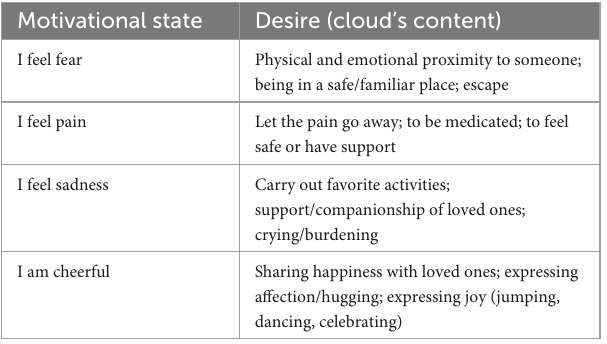
TABLE 2 Summary of the main content reported through the questionnaire, with the aim of determining which motivational aspects were related to certain emotional